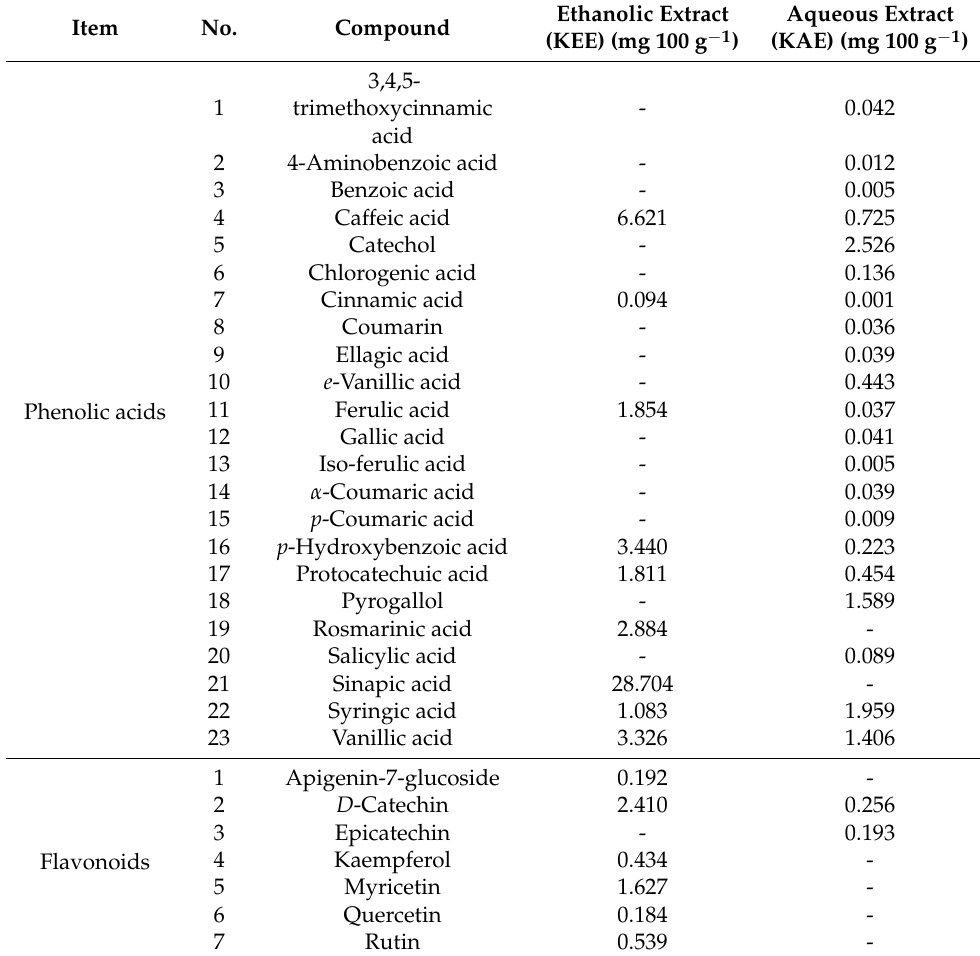
Table 2. Quantitative analysis of phenolic compounds from KEE and KAE of A. hierochuntica by HPLC-DAD.